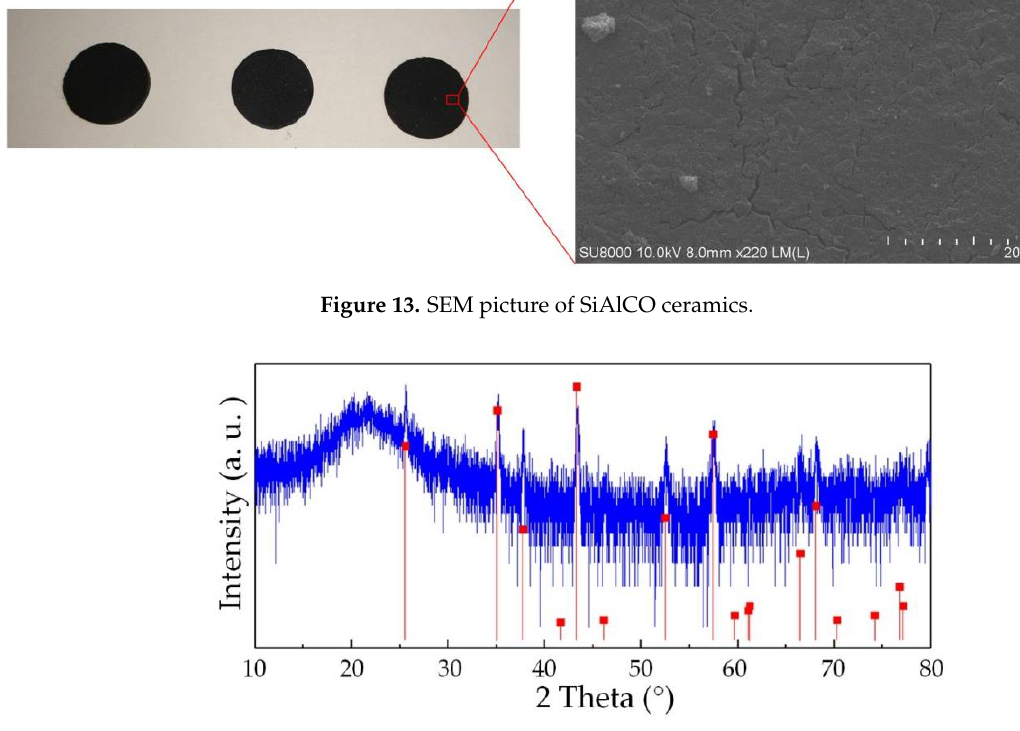
Figure 14. XRD pattern of SiAlCO ceramics.